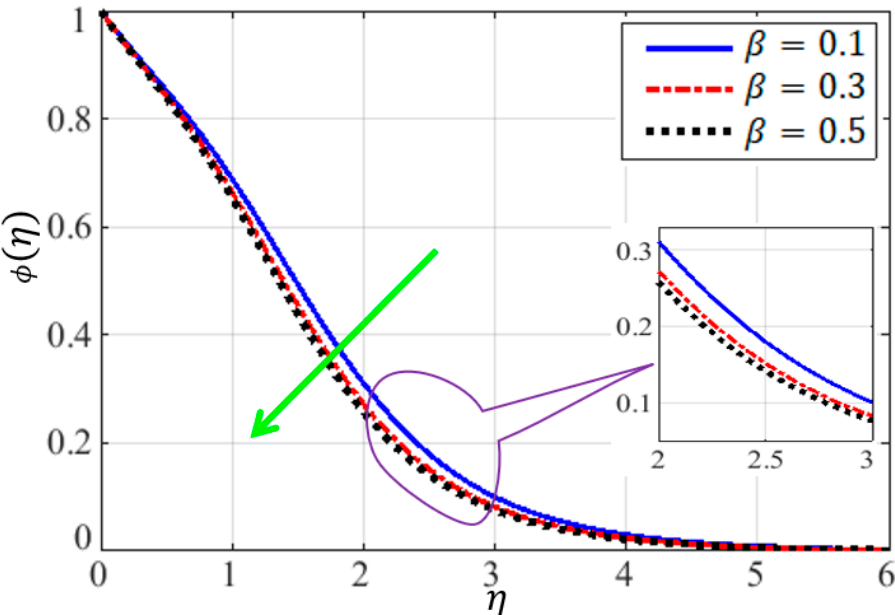
Figure 14. Impact of Casson fl uid viscosity force parameter on fl uid’s concentration fi